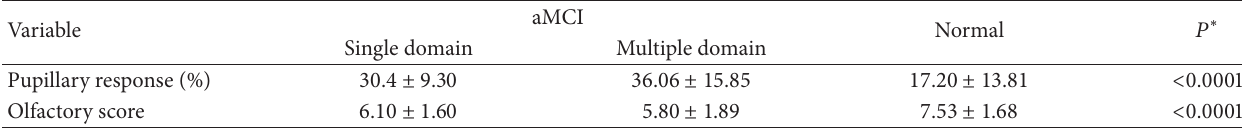
Table 2: Pupillary response and olfactory score in elderly with aMCI and normal